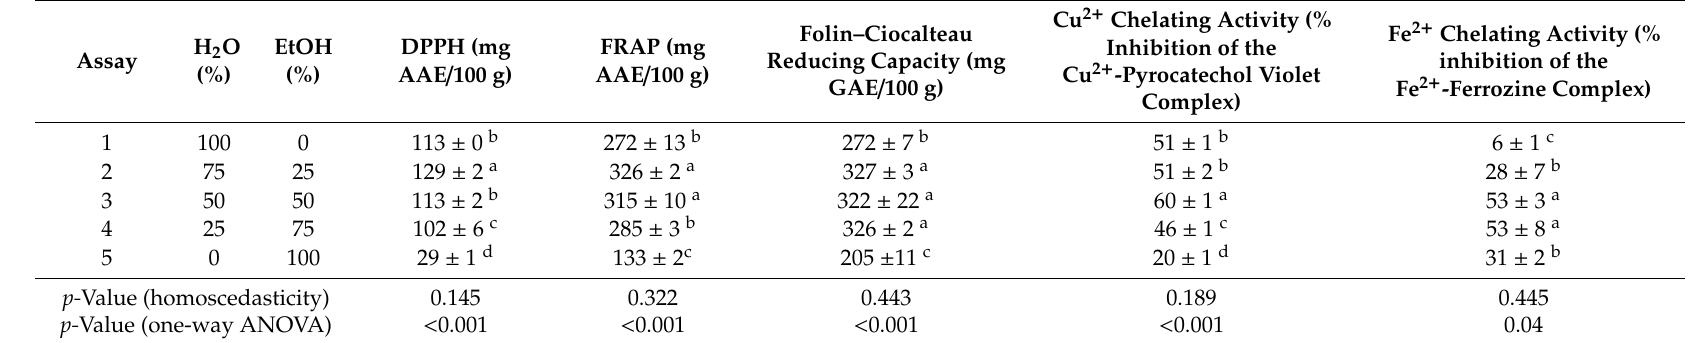
Table 4. Antioxidant activity of Calendula o ffi cinalis flower